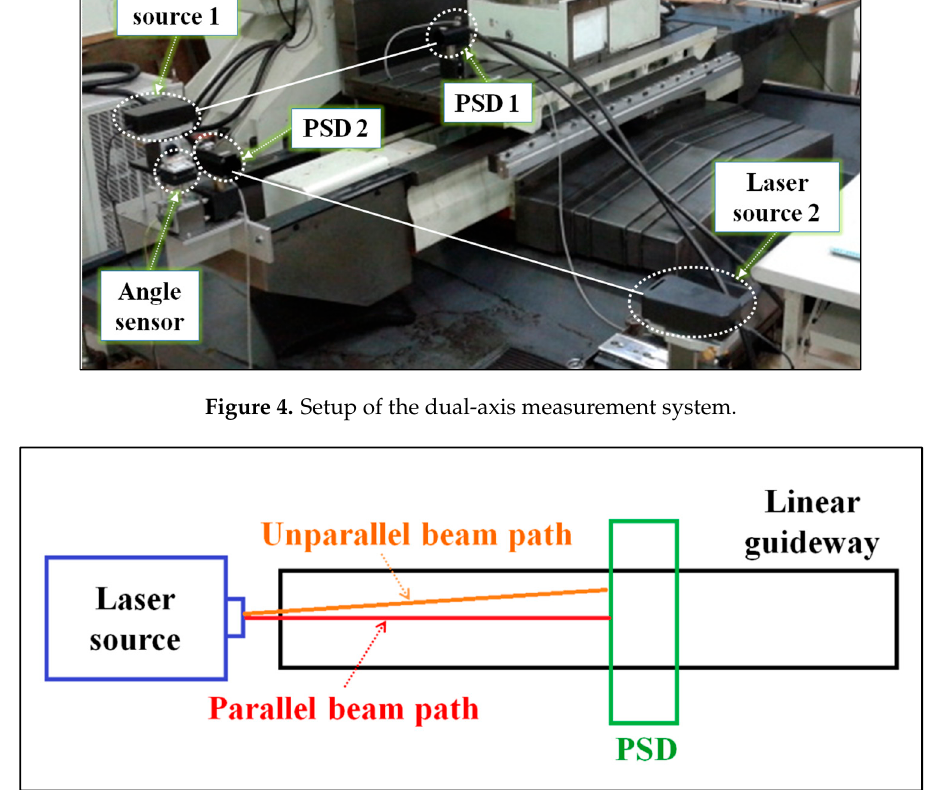
Figure 5. Schematic diagram showing the setup error.